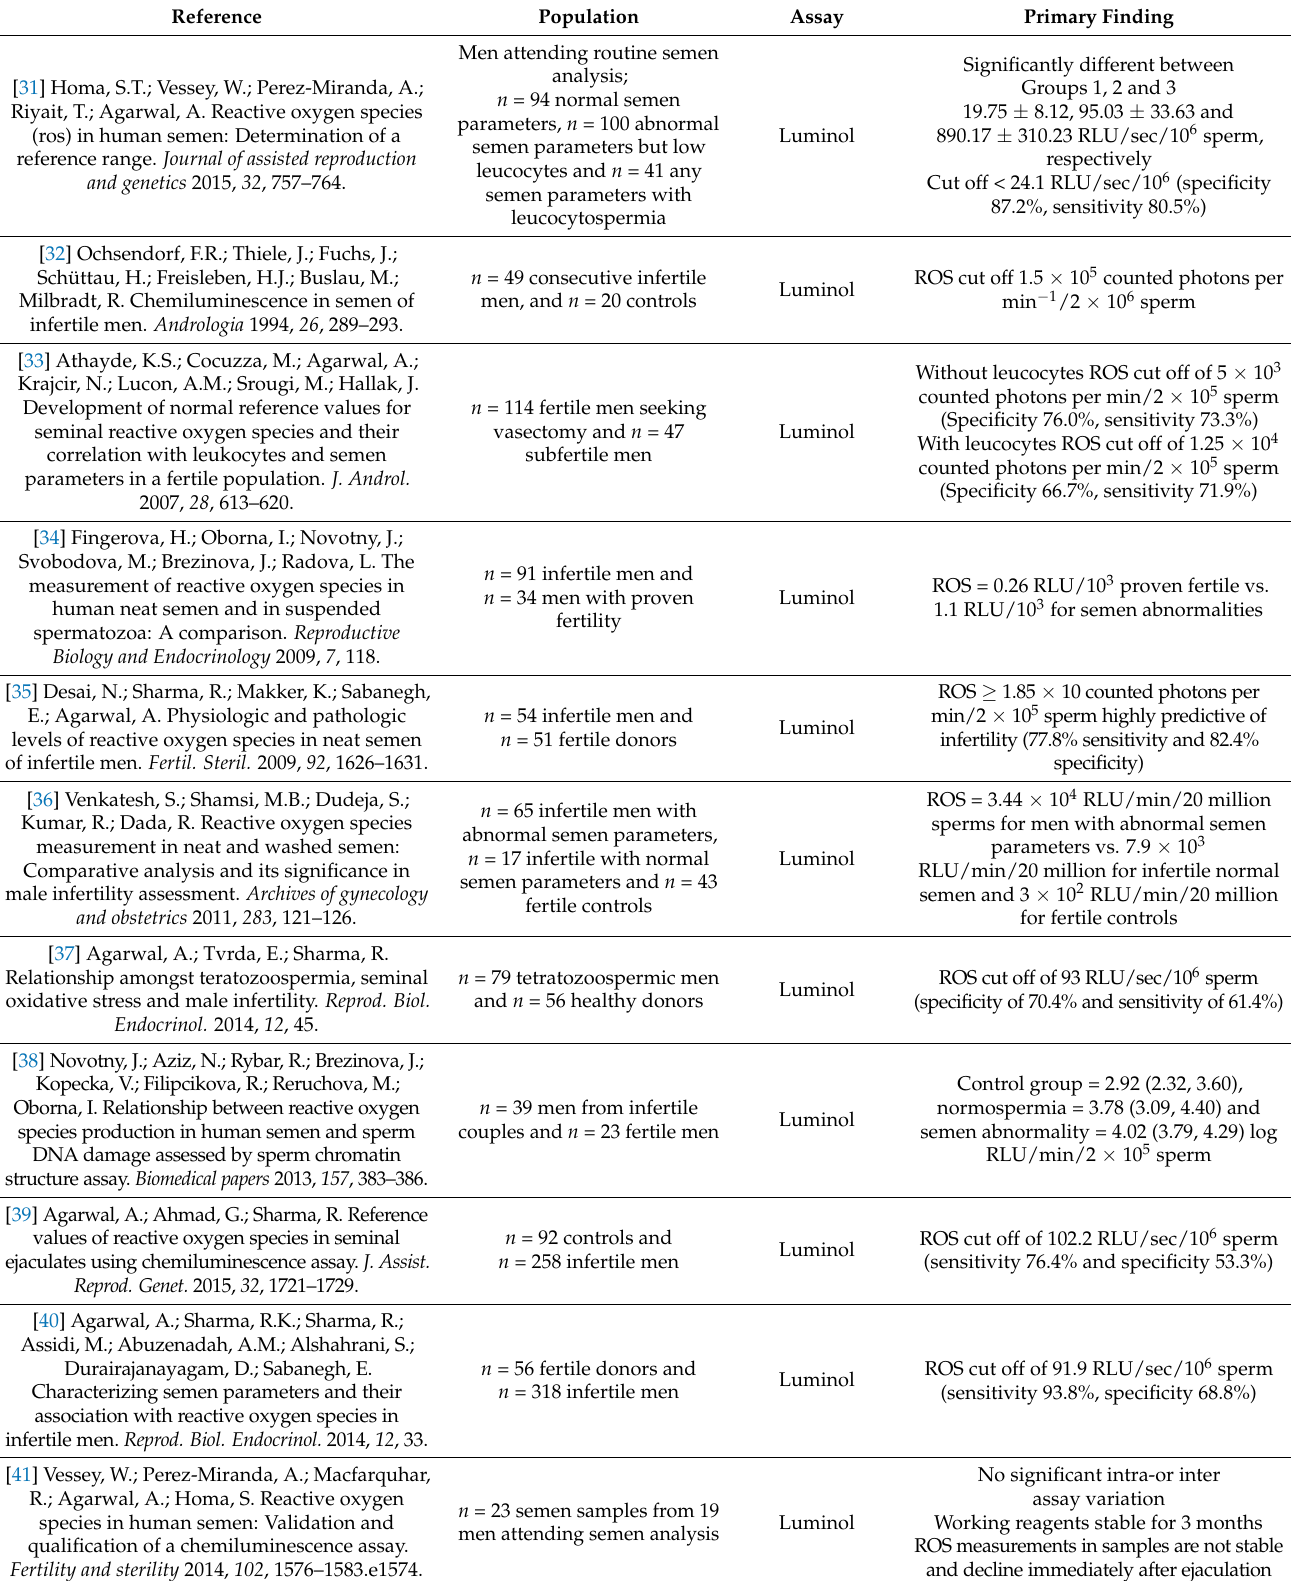
Table 2. Relevant cohort studies assessing/validating Luminol, MiOXSYS and OxiSperm